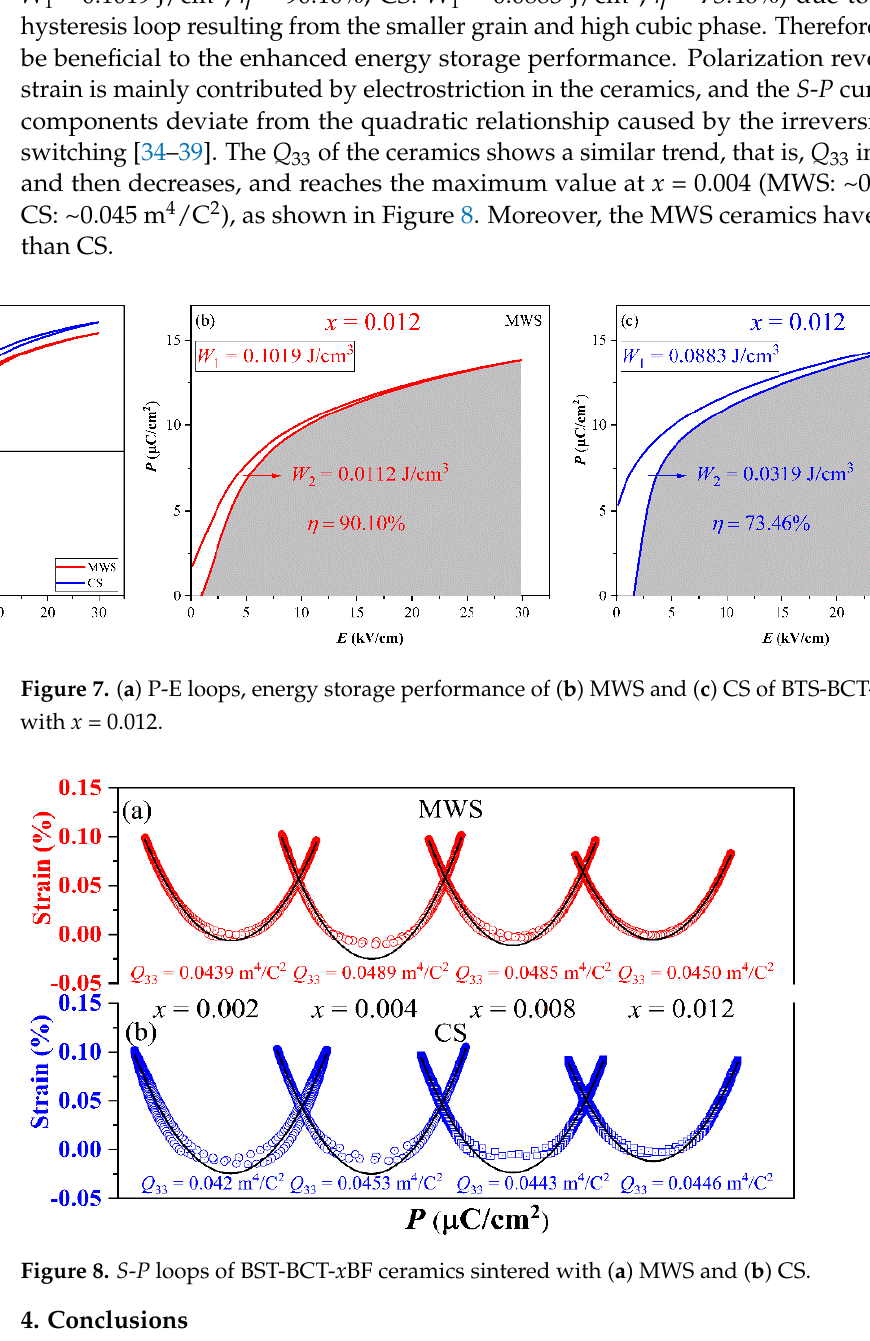
Figure 8. S - P loops of BST-BCT- x BF ceramics sintered with ( a ) MWS and ( b ) CS.